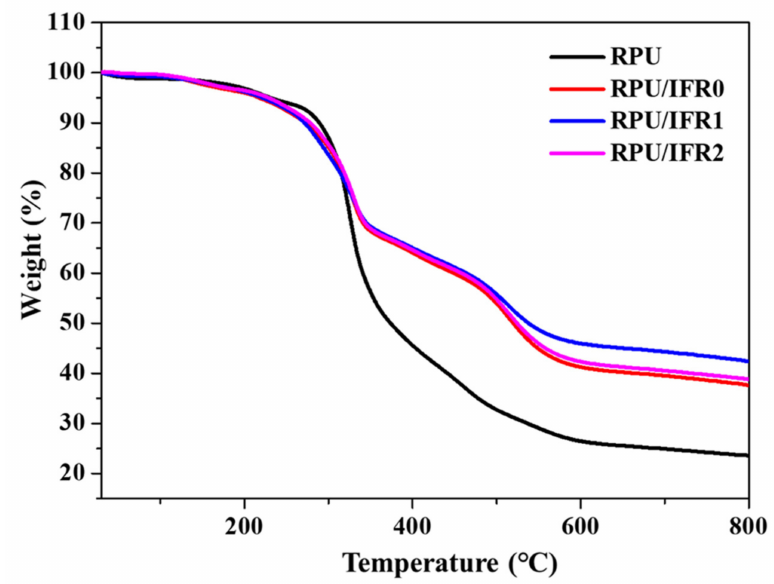
Figure 2. TGA curves of the neat RPU and flame retardant RPU foam samples under a nitrogen atmosphere at a heating rate of 10 ◦